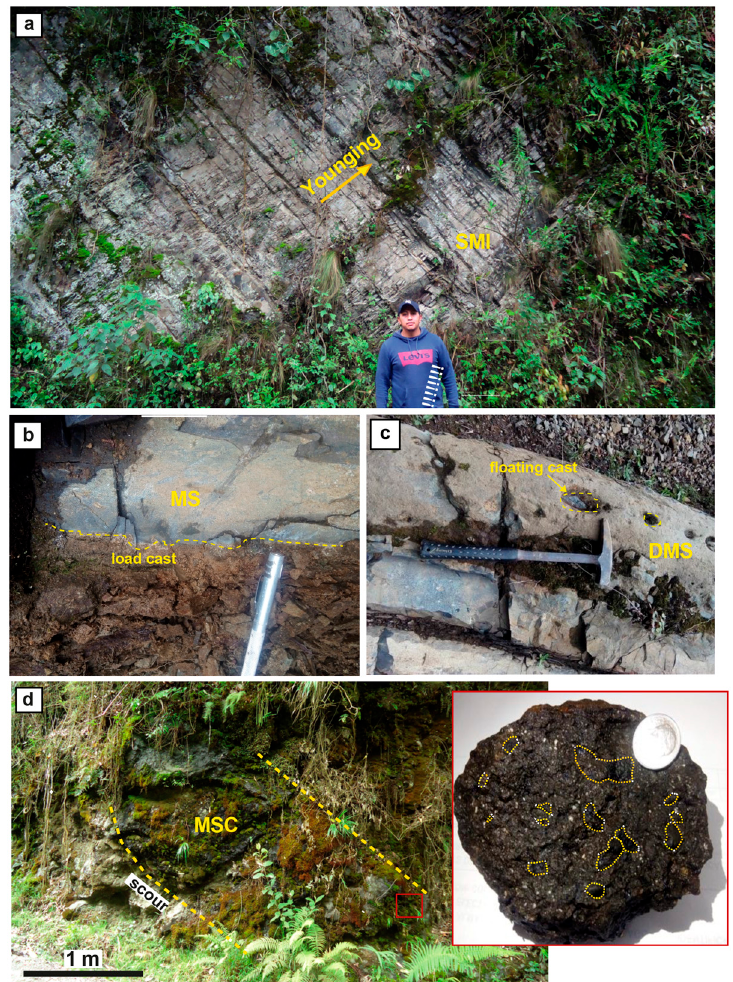
Figure 6. Photographs of representative lithofacies of the Pilalo Formation. ( a ) Lithofacies SMI, siltstone with mud intercalations; ( b ) lithofacies MS, structureless sandstones; ( c ) lithofacies DMS, massive sandstone with floating clasts; ( d ) lithofacies MSC, matrix supported conglomerates.